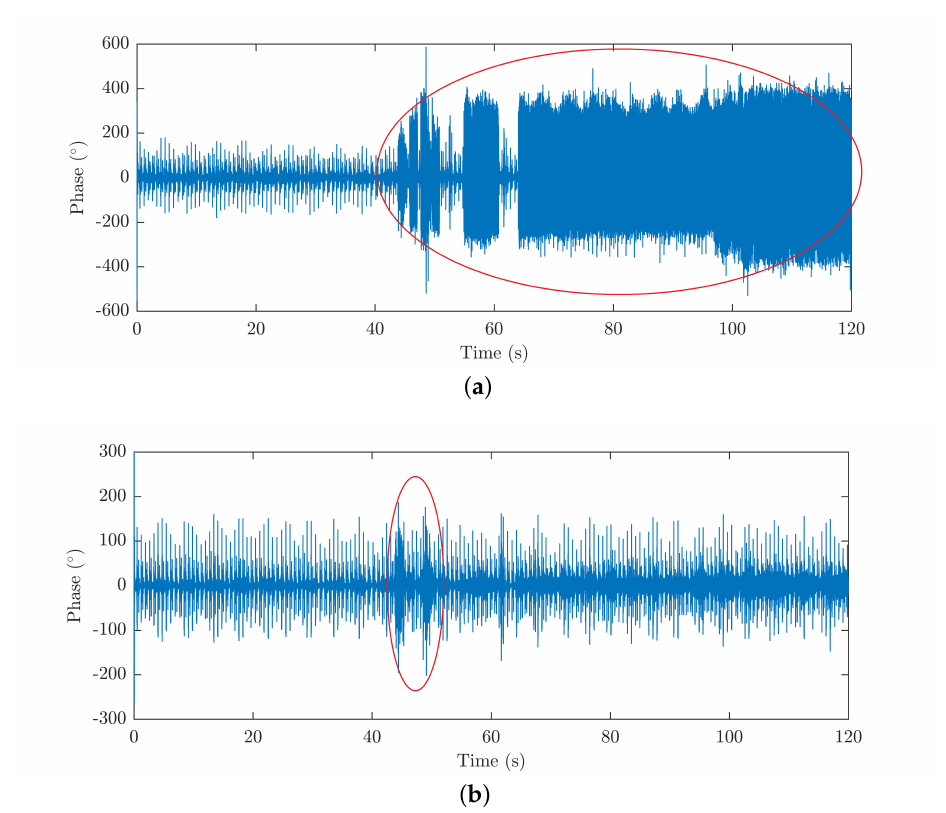
Figure 10. ( a ) Example of a FOI signal from the MRI during the examination; ( b ) suppression of undesirable effects by